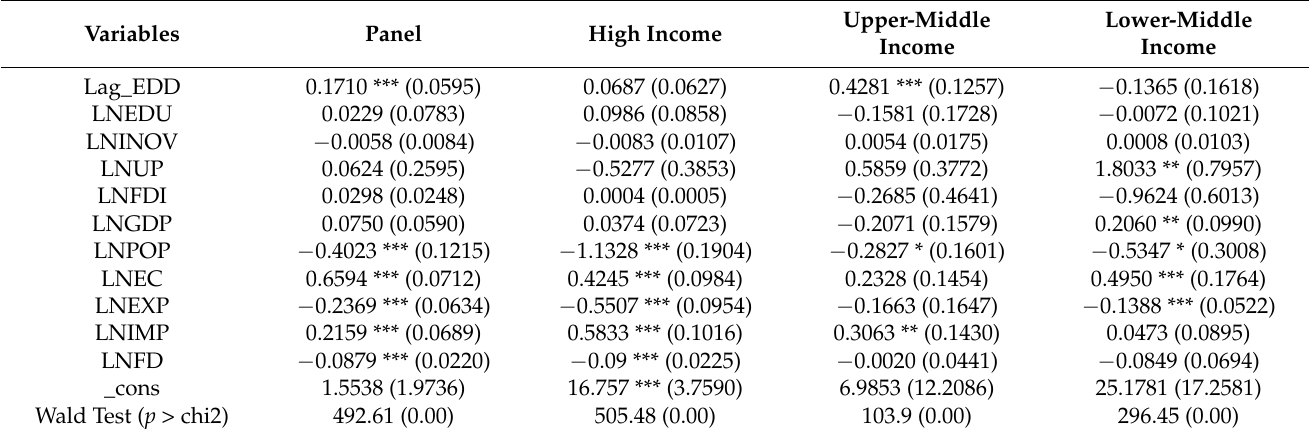
Table 8. Results of Generalized Method of Moments (GMM)